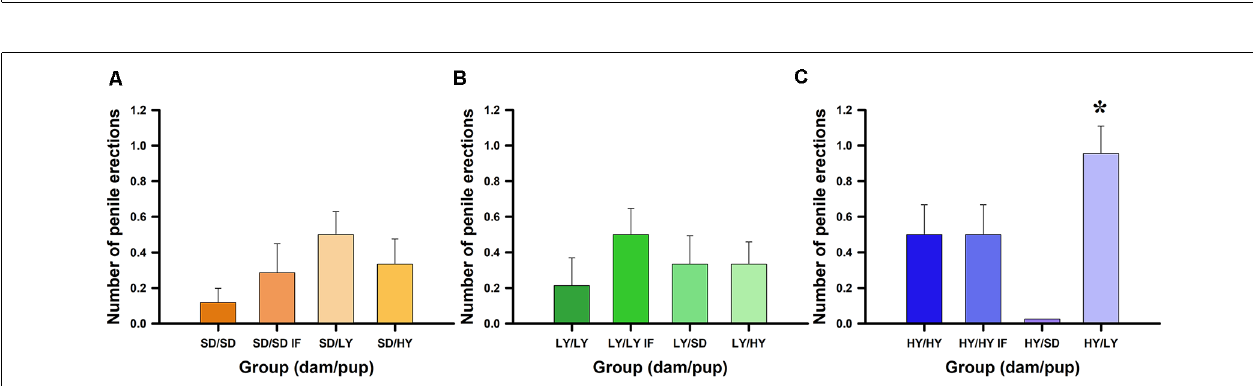
FIGURE 2 | Spontaneous yawning frequency dependents on the dam that take care of male rats. ( A ) Sprague-Dawley (SD) dams do not change the behavioral trend, being the high yawners male rats belonging from HY subline independently of the dam that raised them, see pairs dam/male rats SD/HY (panel A ), LY/HY (panel B ), and HY/HY or HY/HY IF (panel C ); ** P < 0.01. Note that LY dams can reduce yawning frequencies in all pairs LY/LY, LY/LY IF or LY /SD (panel B ). Contrary, HY dams do not increase yawning frequencies in SD or LY male rats (see HY/SD and HY/LY; panel C ).